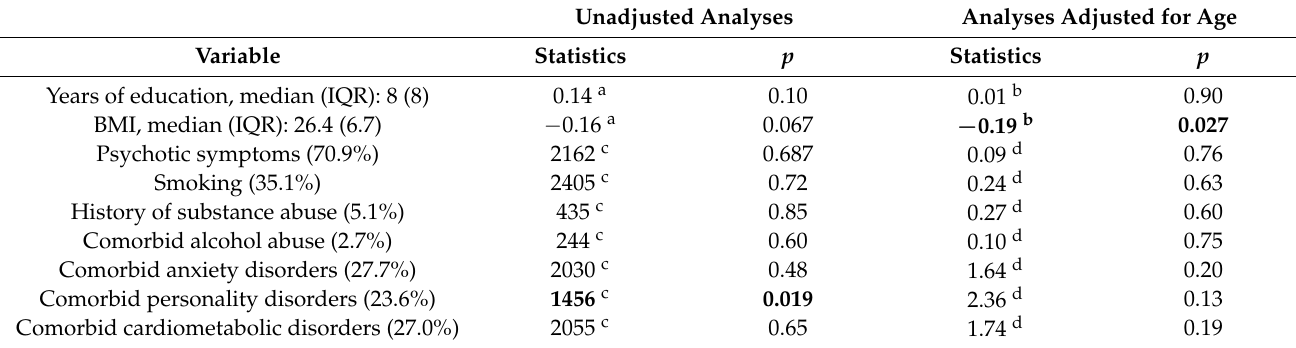
Table 4. Association between LTL and other demographic or clinical variables. Unadjusted Analyses Analyses Adjusted for Age